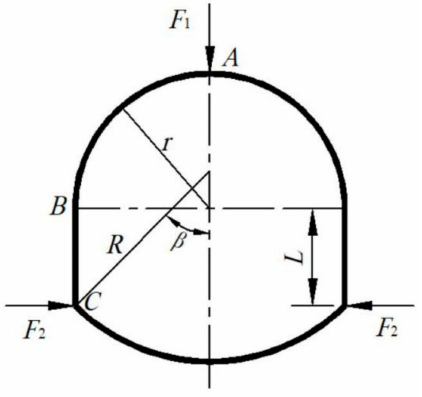
Figure 6. Application method of the displacement